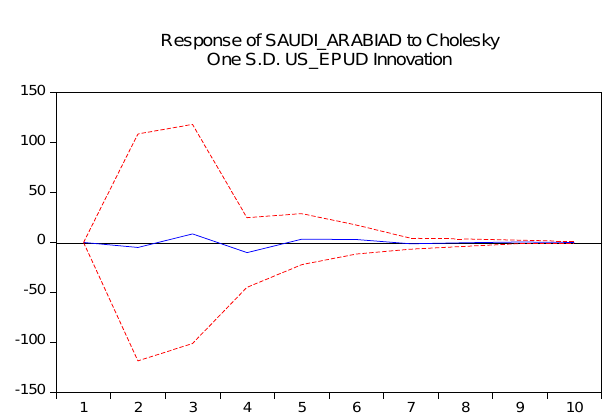
Fig. 5. The impulse response functions of the returns on Saudi Arabia stock